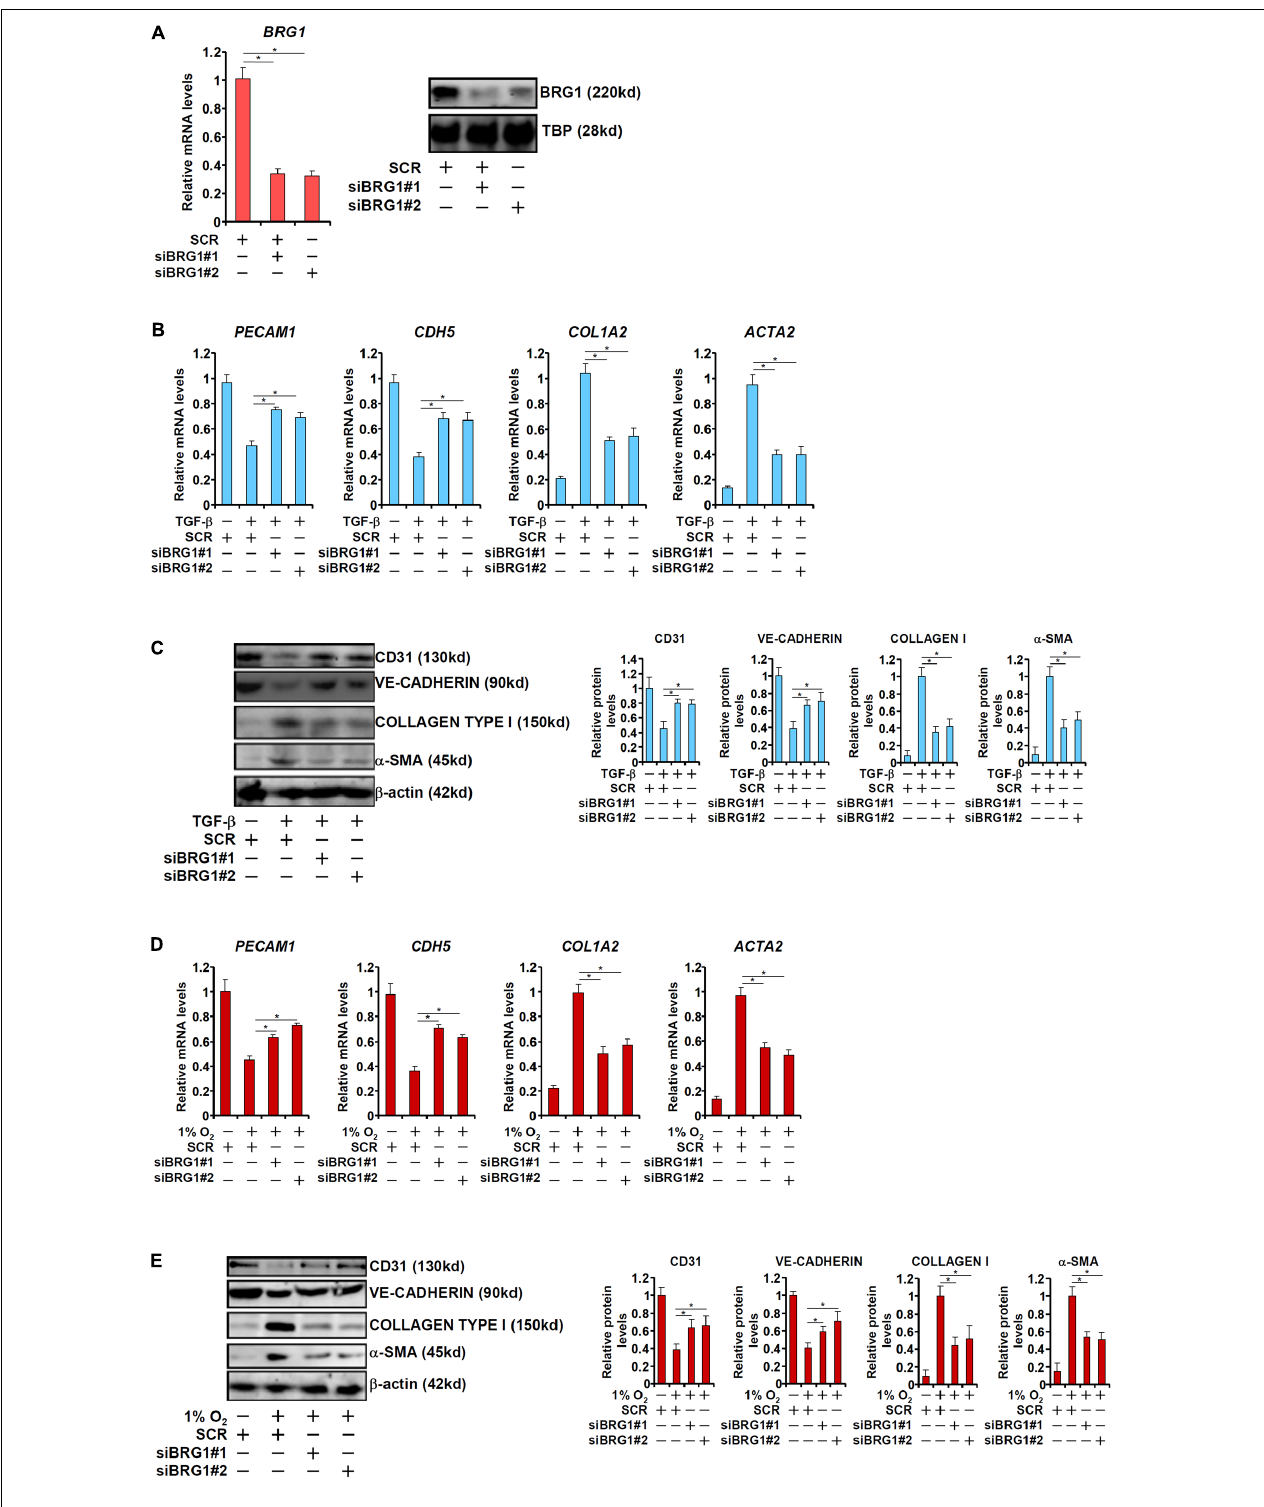
FIGURE 1 | BRG1 is essential for endothelial-mesenchymal transition in vitro . (A) HUVECs were transfected with siRNA targeting BRG1 (siBRG1) or scrambled siRNA (SCR). BRG1 expression was examined by qPCR and Western. (B,C) HUVECs were transfected with siRNA targeting BRG1 or scrambled siRNA (SCR) followed by treatment with TGF- β . Gene expression levels were examined by qPCR and Western. (D,E) HUVECs were transfected with siRNA targeting BRG1 or scrambled siRNA (SCR) followed by treatment with hypoxia. Gene expression levels were examined by qPCR and Western. Error bars represent SEM (* p < 0.05, two-way ANOVA with post-hoc Scheffe test). All experiments were repeated three times and data represent averages of three independent experiments.